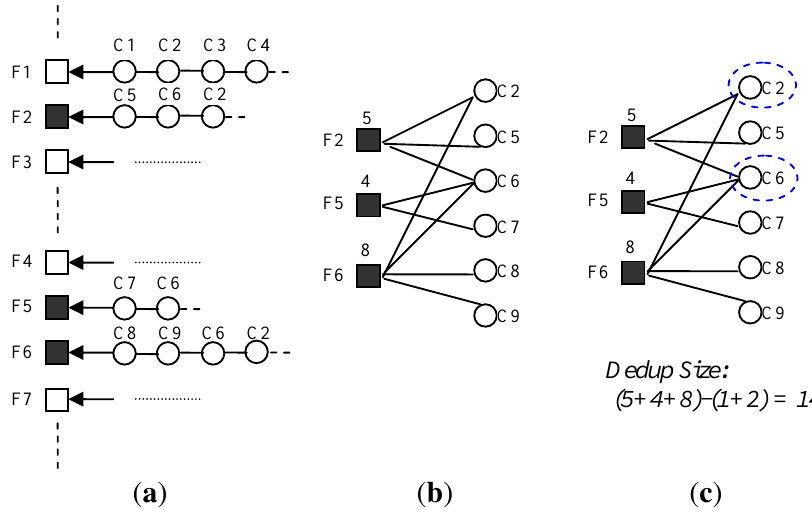
Figure 13. An example of the Graph algorithm. “Initial State” shows the initial state of the metadata, “Step 1” shows the resulting B-Graph of step 1, “Step 2” shows the computation result. ( a ) Initial State; ( b ) Step 1; ( c ) Step